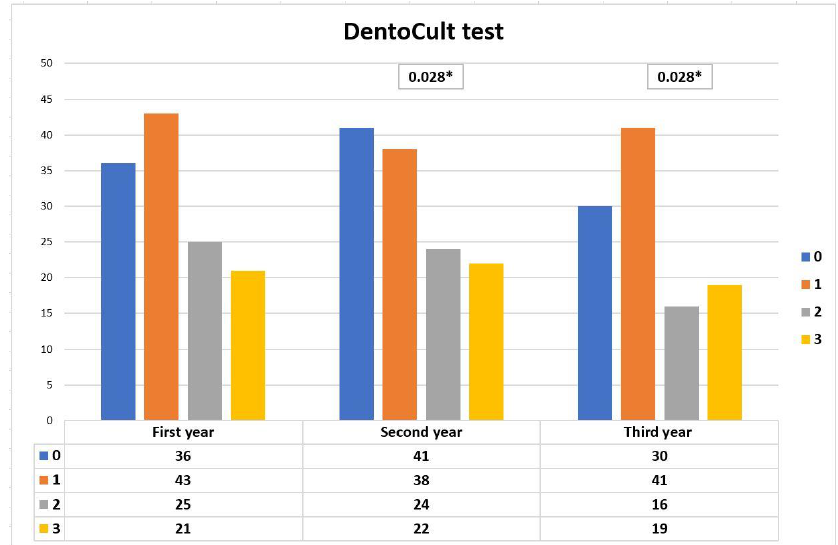
Figure 2. DentoCult SM test scores in the first, second, third year of the study. The statistical analyses were performed using the McNemar’s test, * p < 0.05.